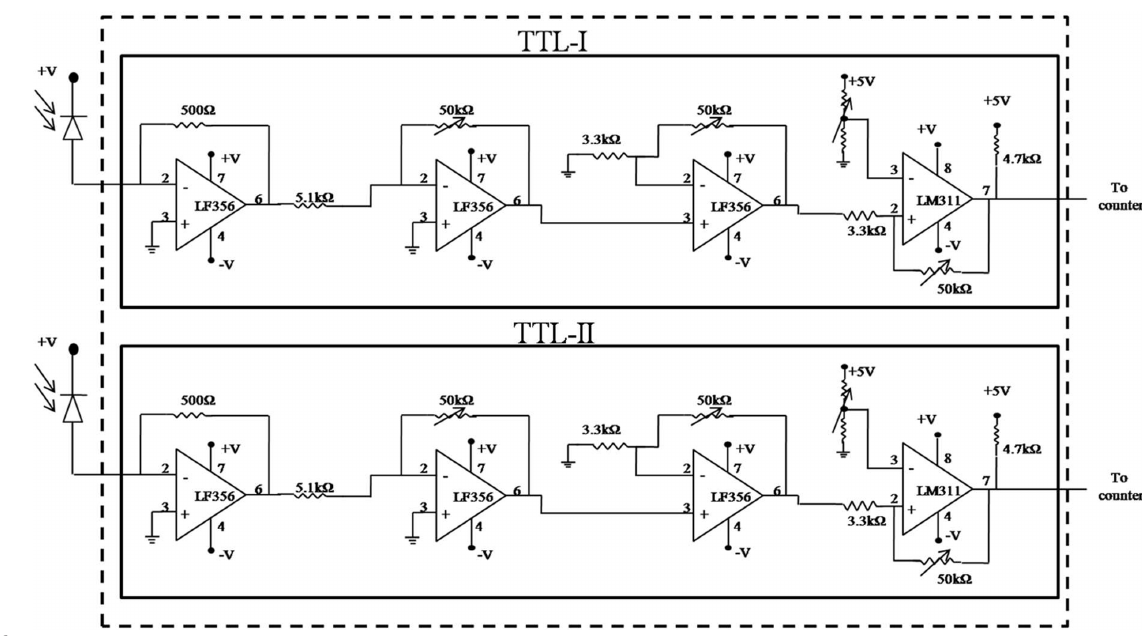
Figure 6 Circuit diagram of the TTL.